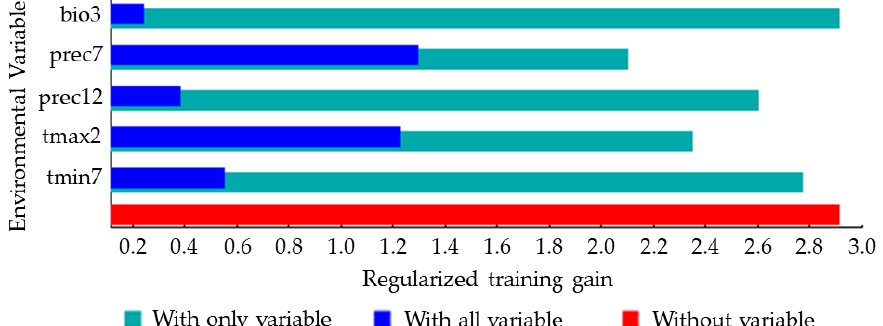
Figure 4. Jackknife analysis result showing most important environmental variables predicting potentially suitable distribution areas of S. nitobei in China. Monthly precipitation in July and maximum temperature in February significantly contributed to explaining the suitability of the area, with monthly precipitation in July and isothermality having the most unique information predicting area suitability for S. nitobei .